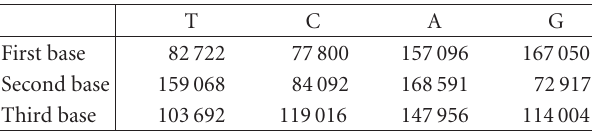
Table 4: Number of nucleotides at the three base sites of a codon in the coding sequence of Aquifex aeolicus .